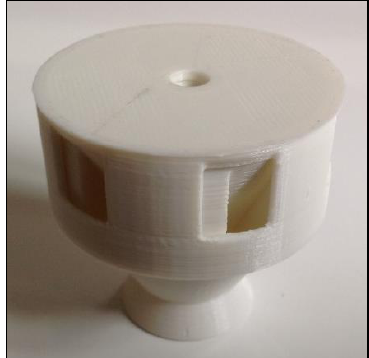
Figure 10. A nozzle block prototype (shown on the left) and a control sleeve (diaphragm) prototype in the working position.